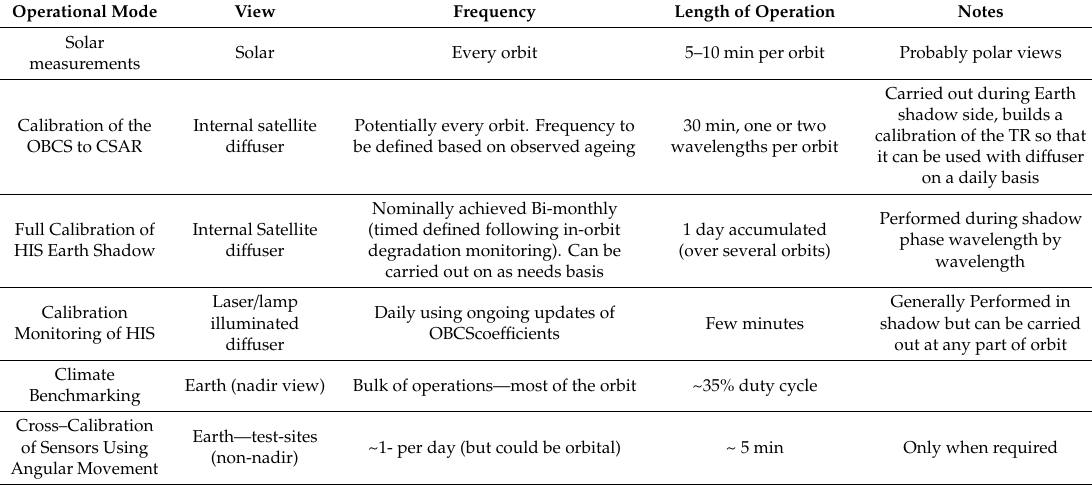
Table 10. TRUTHS operational